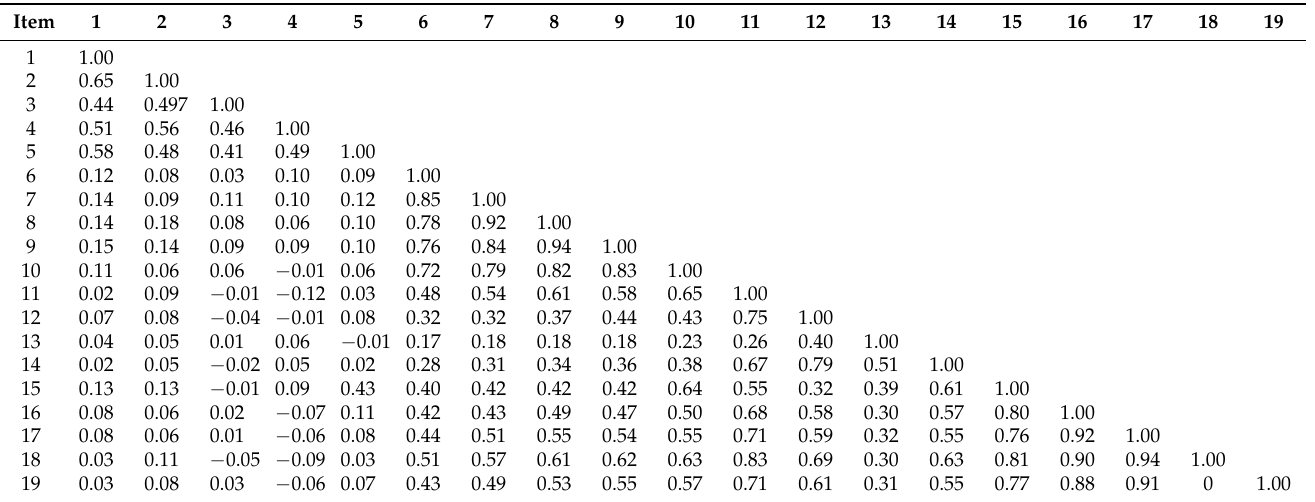
Table 3. Polychoric correlation matrix extracted from the EFA.